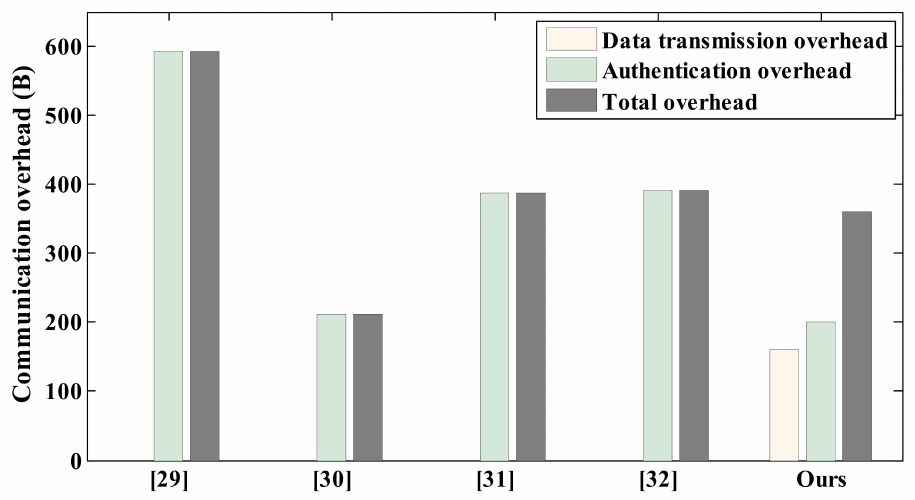
Figure 4. Comparative communication overheads for each protocol